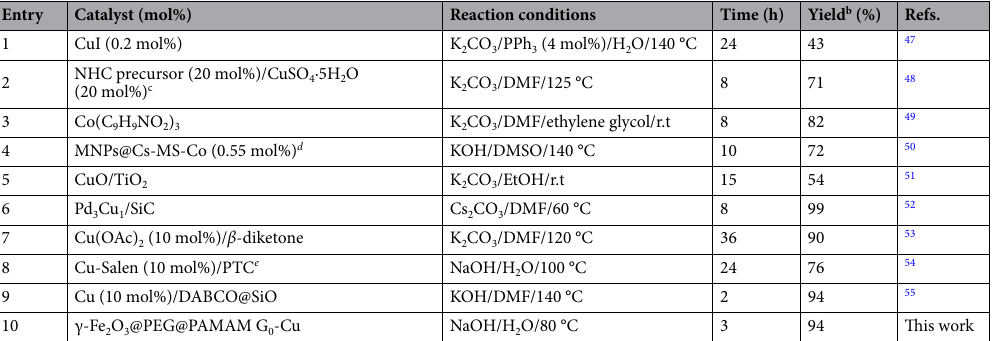
Table 4. Catalytic activity of the γ-Fe 2 O 3 @PEG@PAMAM G 0 -Cu MNPs was compared with reported catalysts for the Sonogashira cross coupling reaction (1a) a . a Sonogashira: reaction of iodobenzene and phenyl acetylene. b Isolated yield. c NHC: N-heterocyclic carbine. d MNPs@Cs-MS-Co: cobalt tagged on MNPs-chitosan functionalized with methyl salicylate. e PTC: phase-transfer